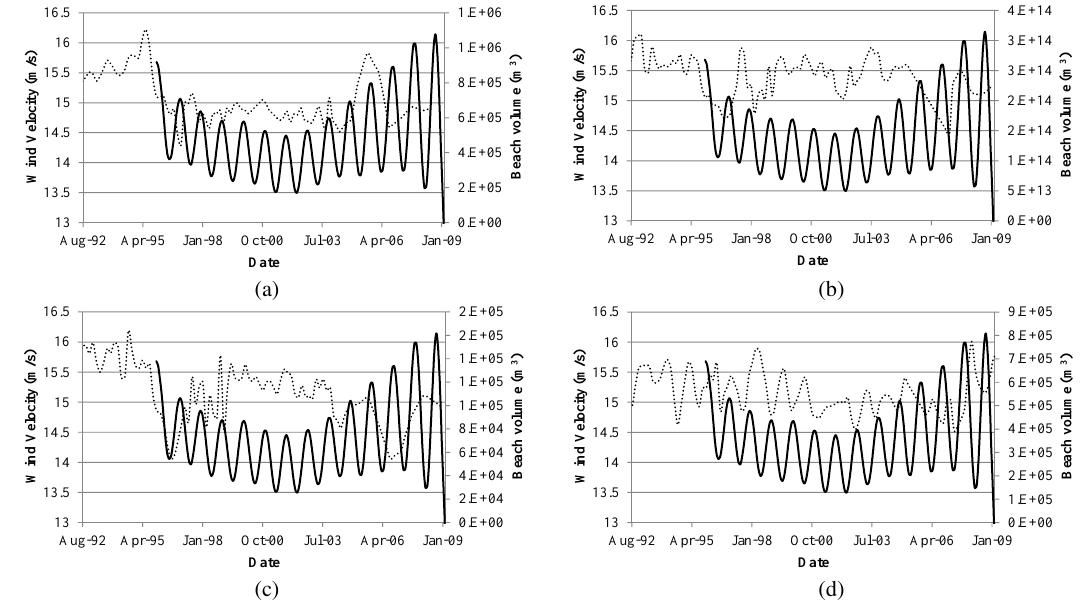
Fig. 10. The relationship between the wind trends (shown by the solid lines) and the beach volume trends (shown by the dotted lines) for the blocks (a) B–F, (b) 1–18, (c) 19–23, (d) BR6–BR9 (refer to Fig. 3).